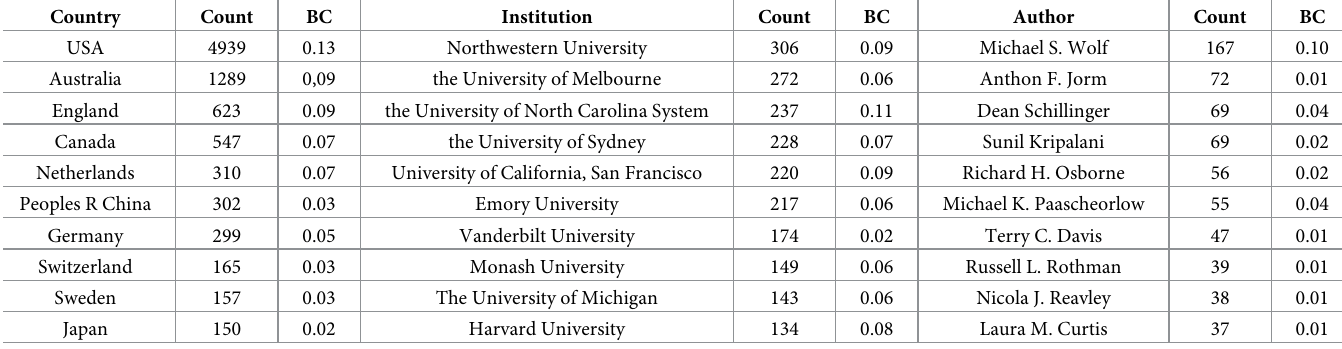
Table 3. Top 10 most productive countries, institutions and authors of health literacy.